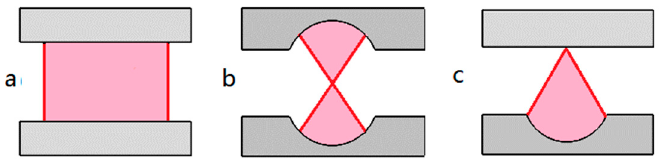
Figure 1. Three configurations of Fabry–Pérot (FP) microcavity, ( a ) plane-plane mirror type (PPFP). ( b ) concave-concave mirror type (CCFP). ( c ) plane-concave mirror type (PCFP).